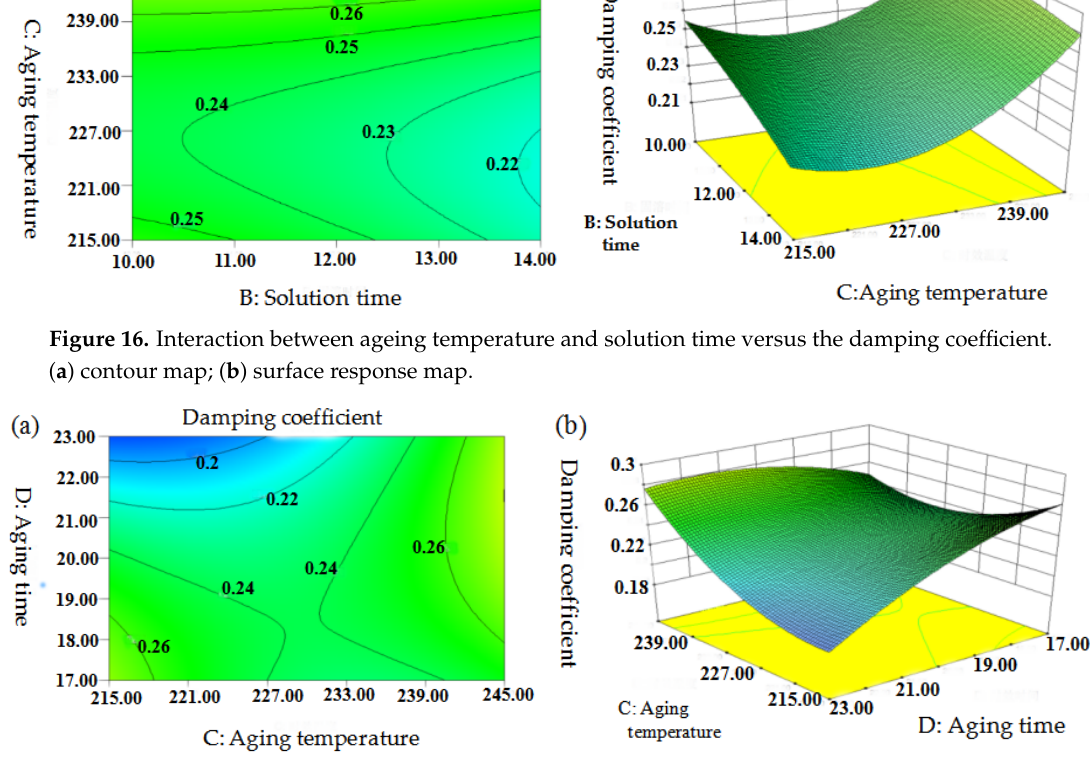
Figure 17. Interaction between ageing time and ageing temperature versus the damping coefficient. ( a )